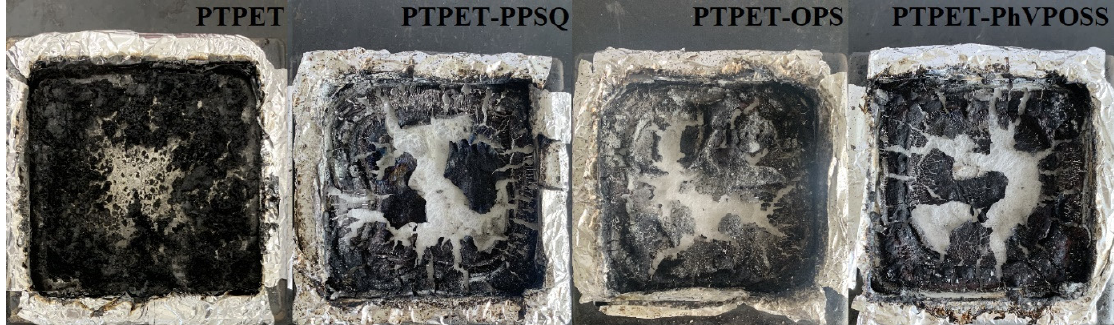
Figure 16. Carbon residues of PTPET elastomer and composites after cone test.